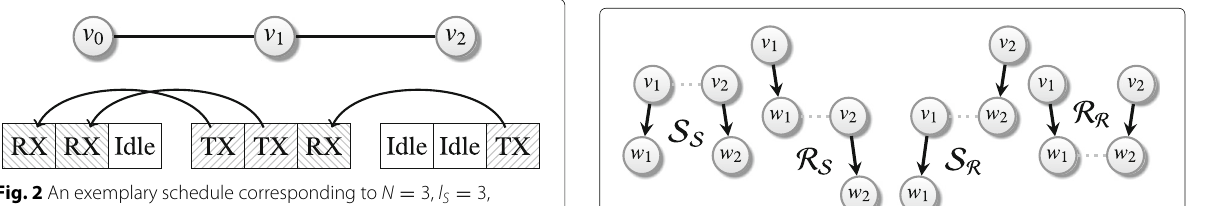
( 0 ) = 1, K 0 ( 2 ) = 2, T 1